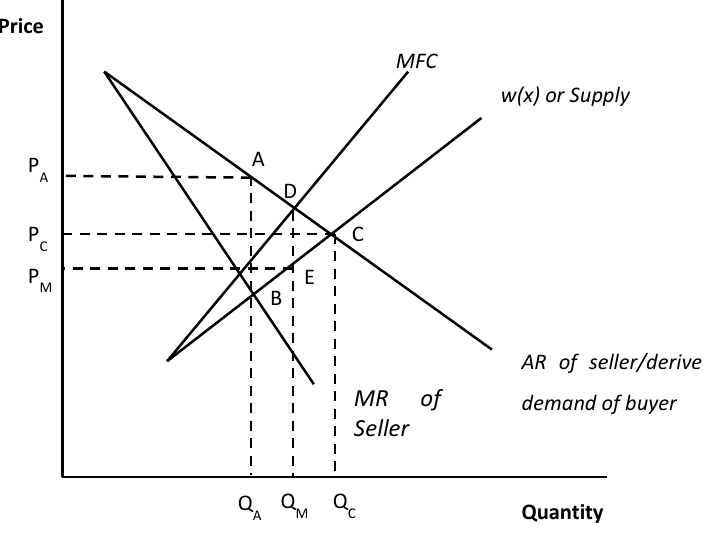
FIGURE 2: Representation of Welfare Effects under a Bilateral Monopoly Market Structure Source: ABA